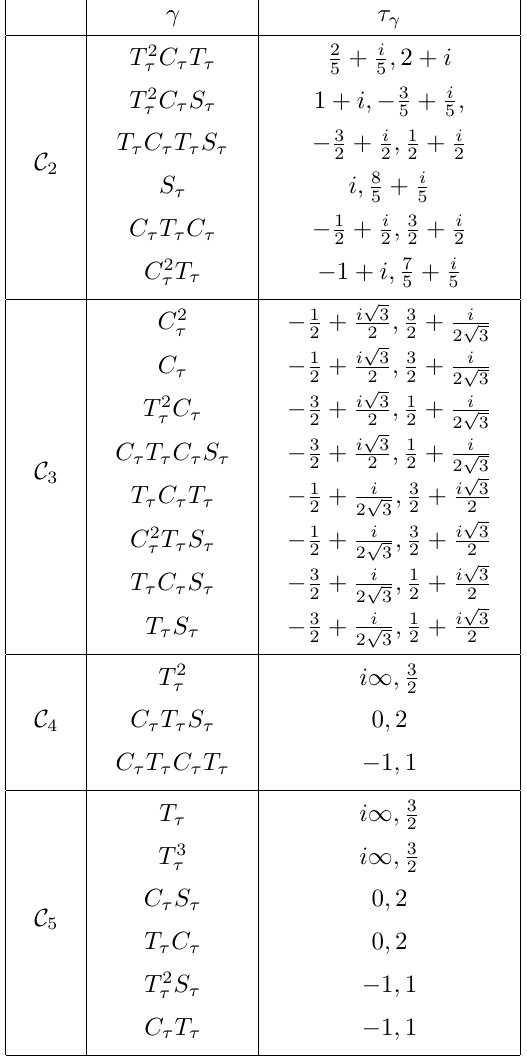
Figure 4 . The fundamental domain D (4) of ¯Γ(4) with the stabilisers of modular transformations of Γ 4 denoted as dots.